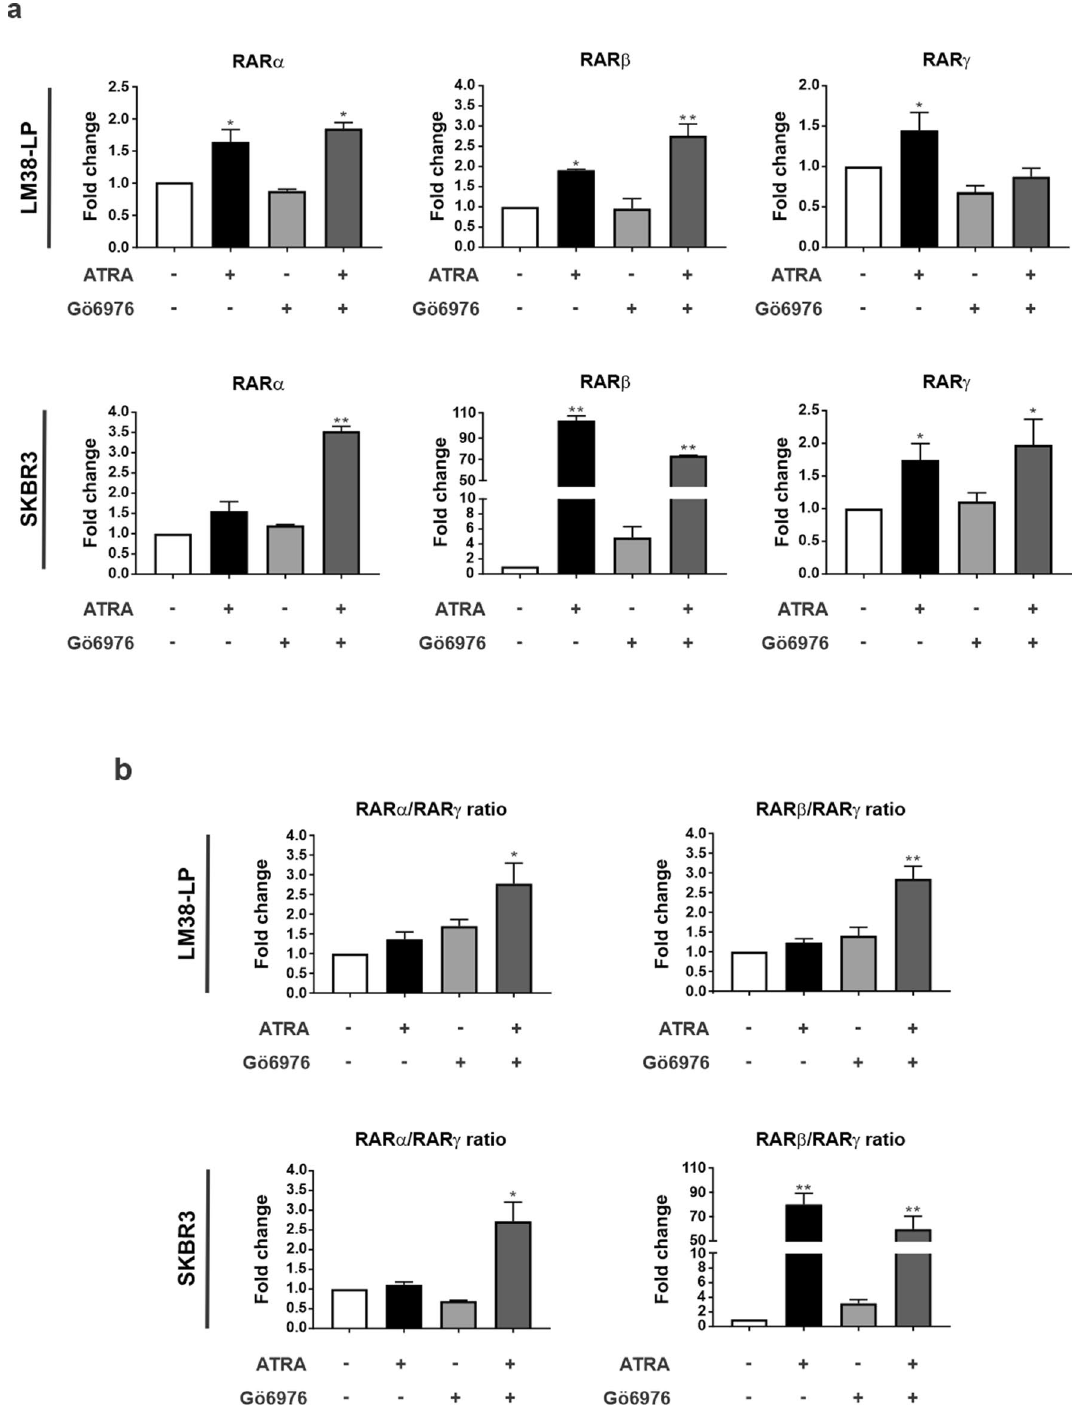
Figure 5. Modulation of Retinoic Acid Receptors. ( a ) LM38-LP monolayers were treated with ATRA (0.5 µM) and/or Gö6976 (0.5 µM) or vehicle as control for 48 h and then RNA was isolated. RARα, RARβ and RARγ expression was analyzed by RT-qPCR. The fold of change of mRNA levels was calculated by normalizing the absolute levels of RARs mRNA, using the ΔΔCt method with GAPDH used as an internal control. Histograms represent mean ± S.D., * p < 0.05 versus control, ** p < 0.01 versus control (ANOVA test). Results are representative of three experiments. ( b )Evaluation of RARα/RARγ and RARβ/RARγ expression ratio. LM38-LP and SKBR3 cells were treated with ATRA (0.5 µM) and/or Gö6976 (0.5 µM) or vehicle as control for 48 h. GAPDH was used as an internal control. Histograms represents mean ± S.D., * p < 0.05 versus control, ** p < 0.01 versus control (ANOVA